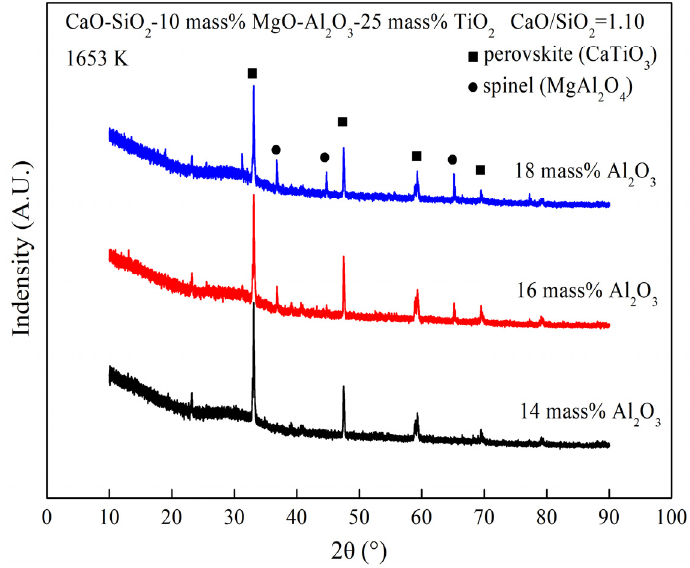
Figure 9. XRD curves of the slag containing different Al 2 O 3 content at 1653 K.